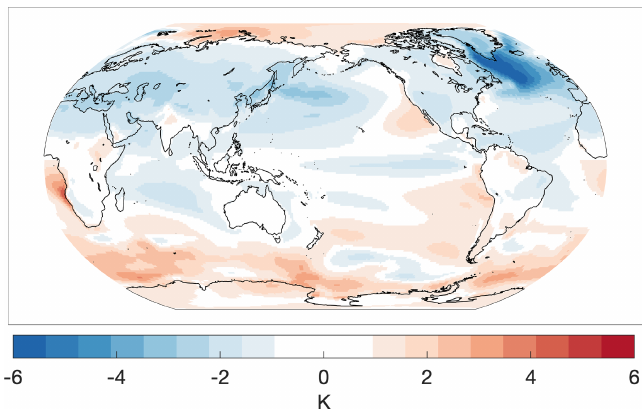
Code and data availability. The E3SM and MERRA2